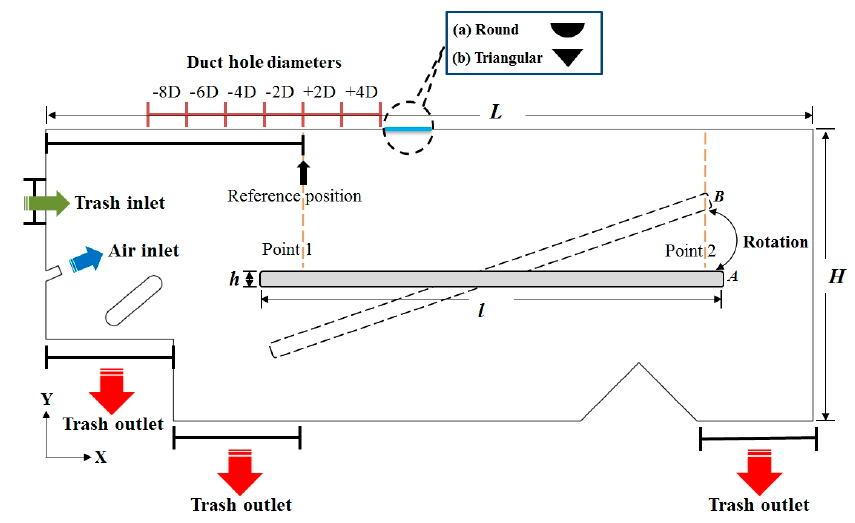
Figure 1. Computational model set-up of the air-based density separator system.